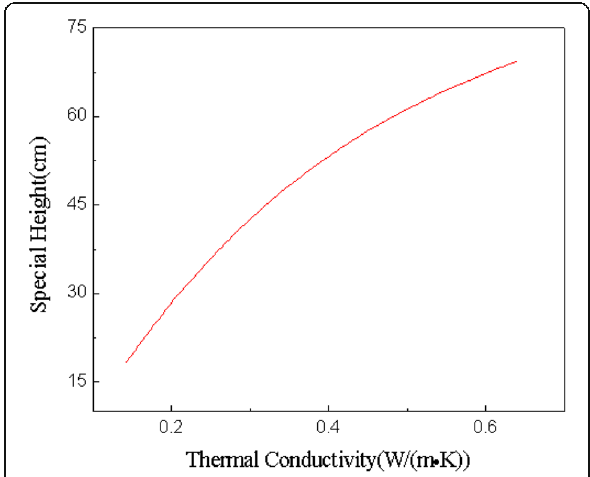
Fig. 8 Relation diagram between thermal conductivity and special height